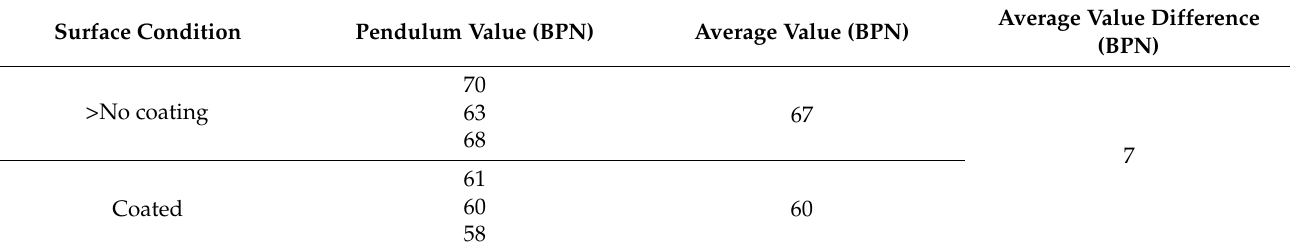
Table 9. Asphalt pavement anti-skid pendulum value.